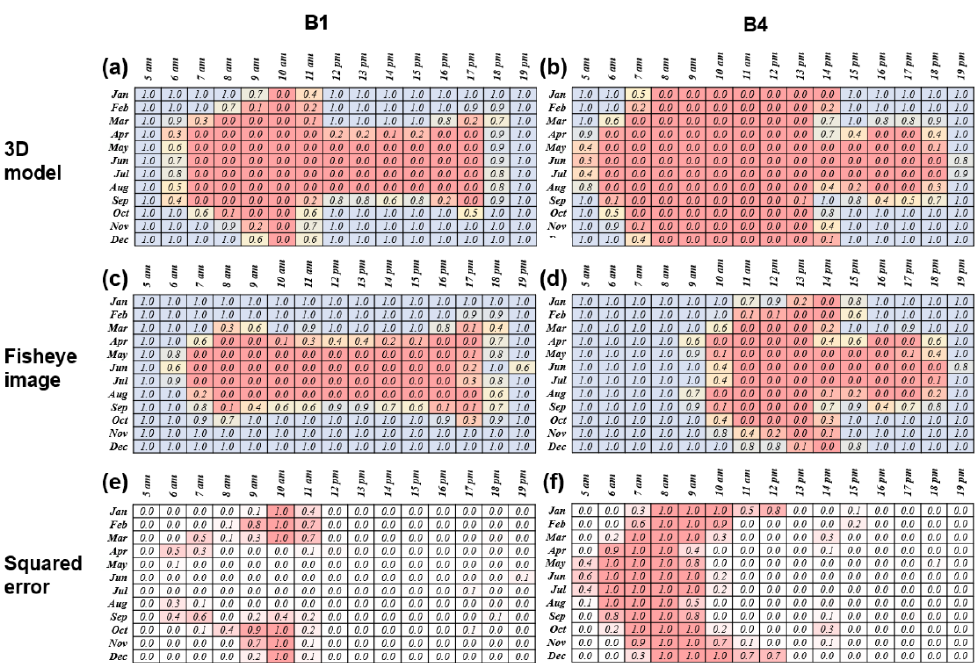
Figure 13. Shading matrices obtained at survey points B1 and B4 using 3D models ( a , b ) and fisheye images ( c , d ), respectively. Squared error matrices between two shading matrices at survey points ( e ) B1 and ( f ) B4.